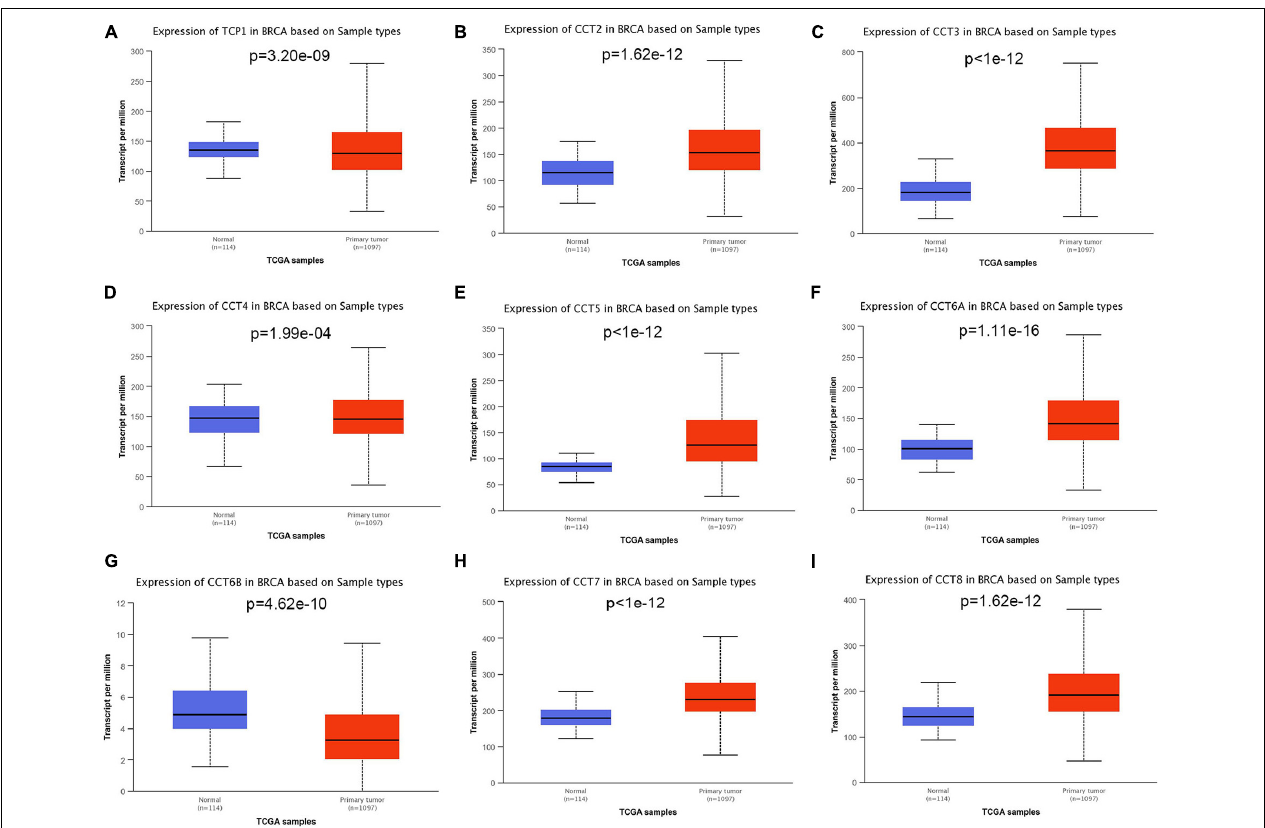
FIGURE 1 | Boxplot showed relative expression of eight subunits of the chaperonin TRiC in BCa primary tumor and in corresponding normal tissues based on UACLAN database. (A) TCP1, (B) CCT2, (C) CCT3, (D) CCT4, (E) CCT5, (F) CCT6A, (G) CCT6B, (H) CCT7, and (I)